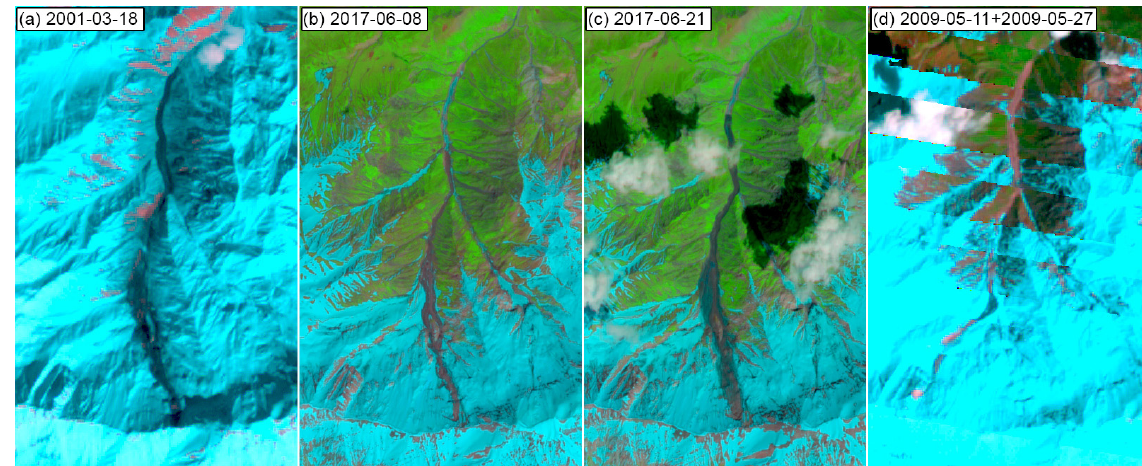
Figure A5. (a–c) Rock avalanches traveling over glaciers in the eastern part of the Shikorchi catchment. (a) L7 of the shi-01 rock avalanche (18 March 2001). (b, c) S2 images of the first and second shi-17 rock avalanches (8 and 21 June 2017). (d) The shi-09 rock avalanche in the western part of the catchment (image composed from two L7 images from 11 and 27 May 2009. Landsat-7 image courtesy of the US Geological Survey. Copernicus Sentinel data